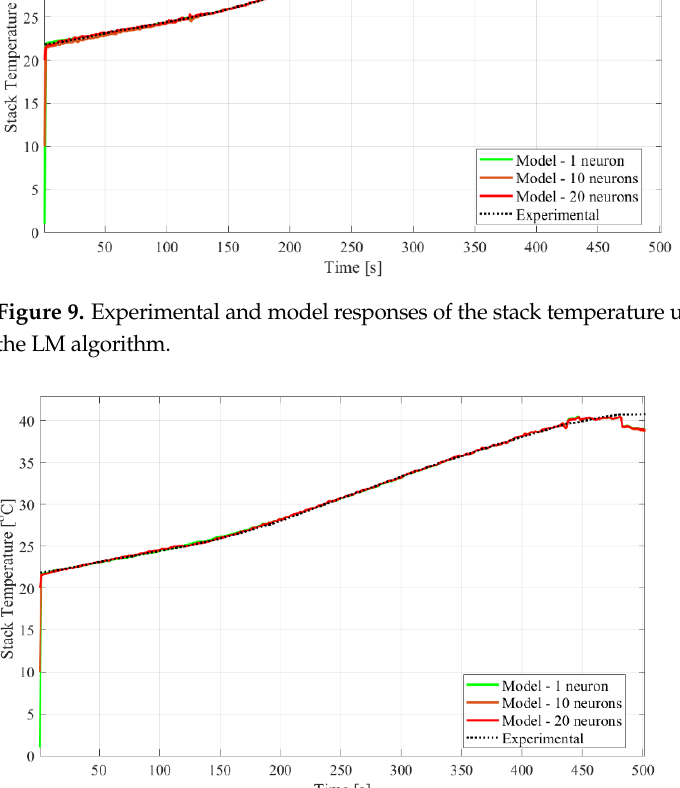
Figure 10. Experimental and model responses of the stack temperature using an ANN with the Bayesian-based algorithm.